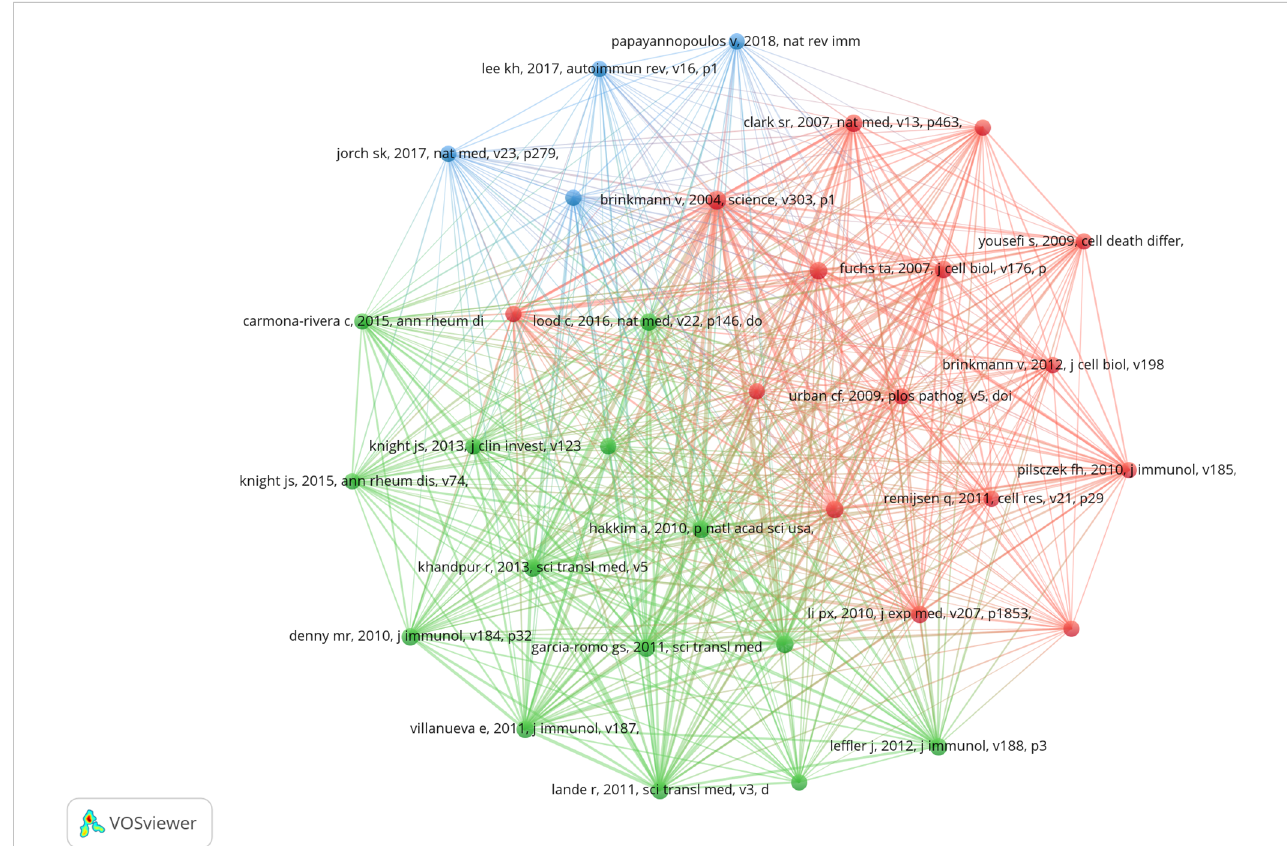
FIGURE 7 Visualization of co-cited references on the research of exosomes in